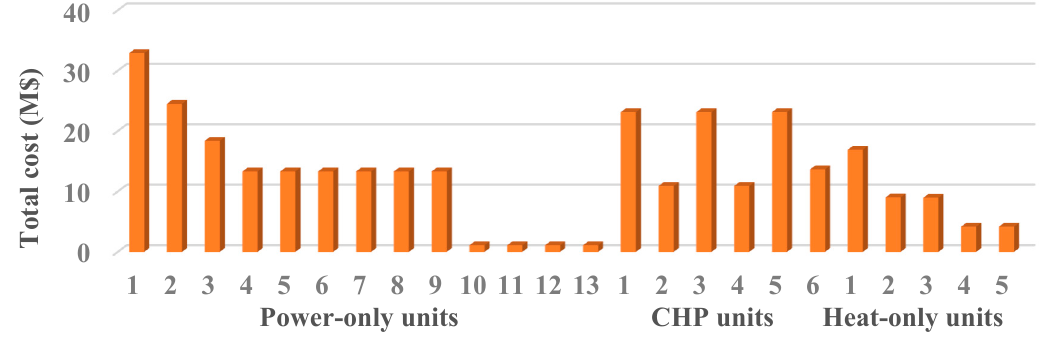
Figure 17. Total cost of the units in the long-term plan.